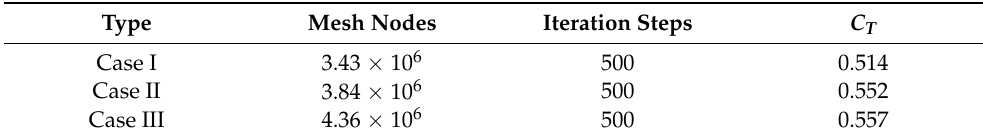
Table 2. Comparison of calculation results.